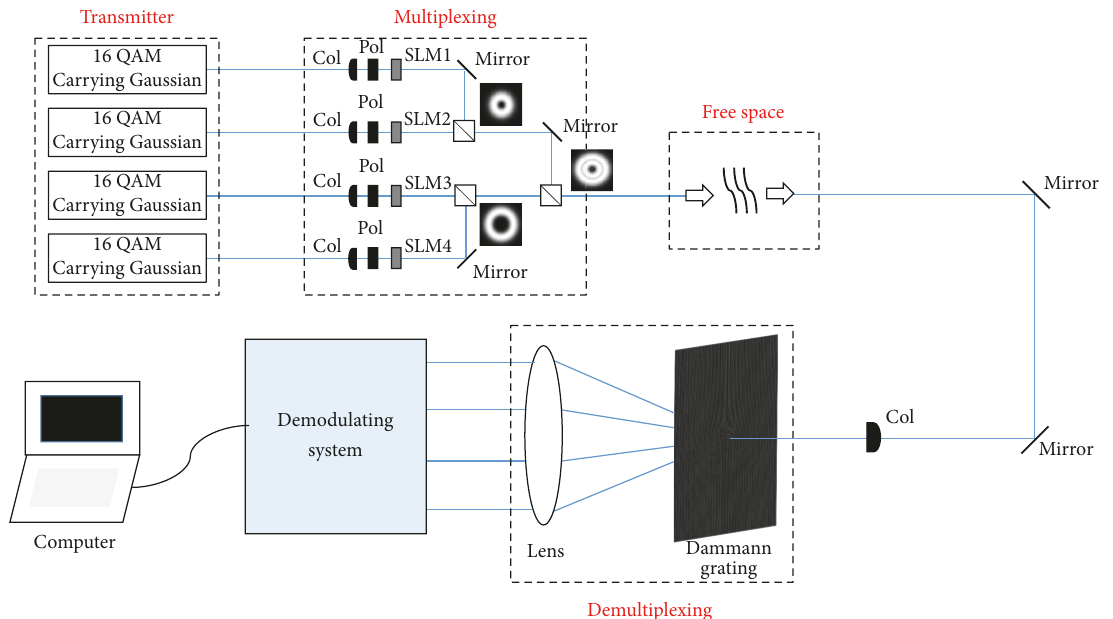
Figure 5: The OAM optical communication system.